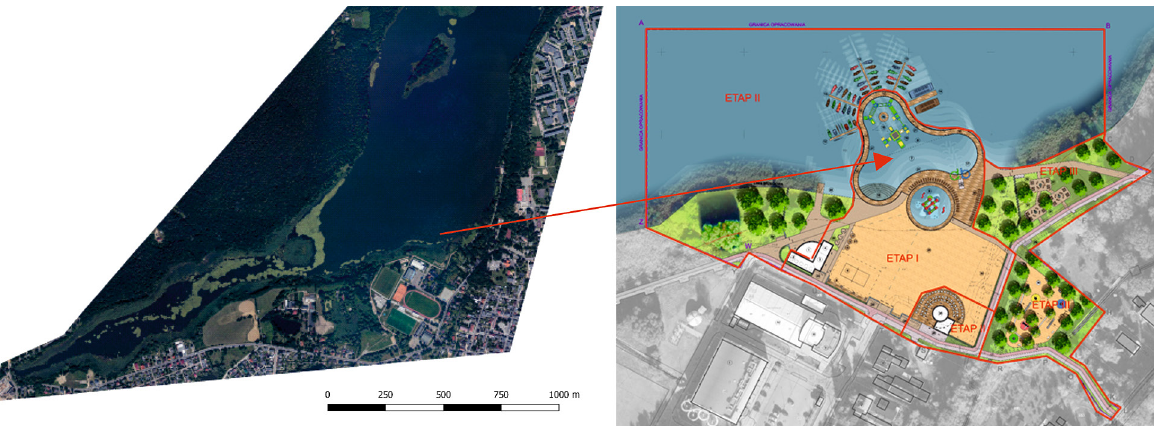
Fig. 10. Ortophotomap of the Lake Swarzędzkie presenting the current state of reservoir management